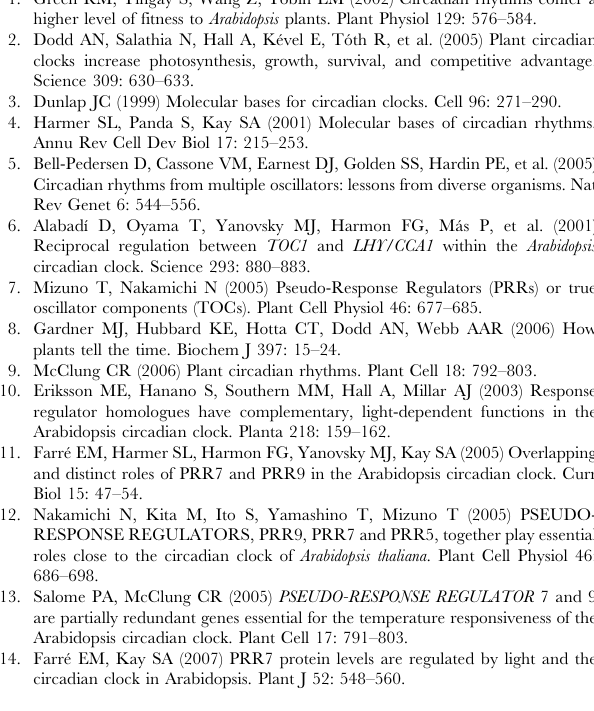
Figure S2 CsPRR gene expression in the leaves of chestnut seedlings grown under different temperature conditions. (A and B) leaves from seedlings grown under conditions of LD and 22 u C. (C and D) leaves from seedlings grown under standard conditions (LD, 22 u C) and subsequently subjected to one week of LD at 4 u C. Samples were collected at 3-h intervals. (A and C) CsPRR northern blot analysis. The rRNA loading reference was detected by staining gels with ethidium bromide. (B and D) Quantitative RT- PCR analysis. Relative transcript abundances are shown in the graphs. Data are means from two biological replicates. Open and filled bars above each graph indicate lights on and lights off, respectively. Found at: doi:10.1371/journal.pone.0003567.s002 (0.62 MB